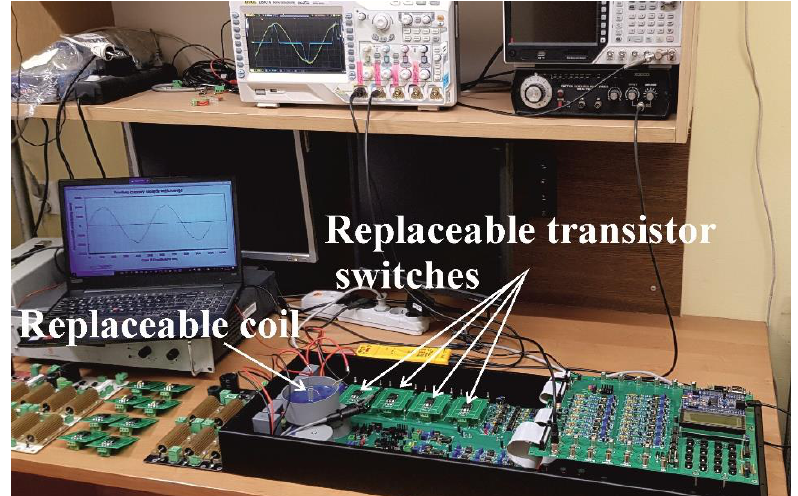
Figure 15. The experimental VSI shows the replaceable coil and transistors.